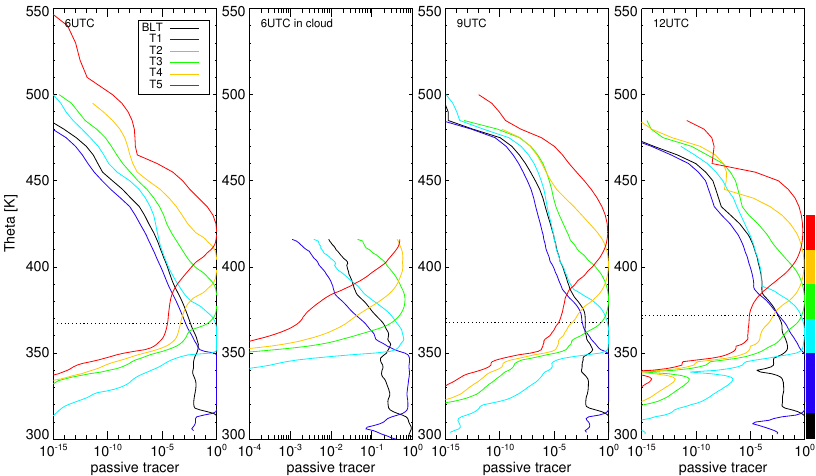
Figure 7. Domain average profiles of passive tracers BLT and T1–T5 at 06:00UTC (left), 09:00UTC (second from right), and 12:00UTC (right), and in-cloud averages at 06:00UTC (second from left). The coloured blocks on the right indicate the initialisation layer of the respective passive tracer, in which the tracers have a value of 1; they are 0 outside the